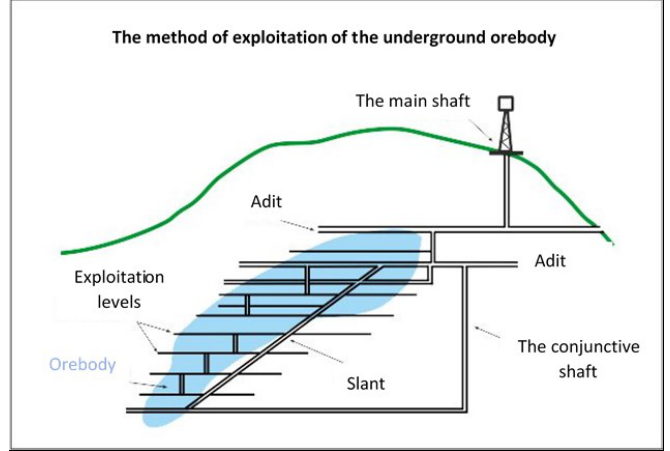
Figure 7. Scheme of the old arsenic and gold mine in Złoty Stok (based on the figure from: geoportal.